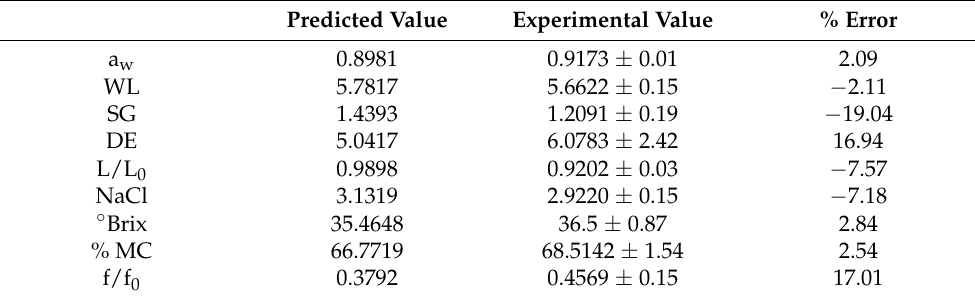
Table 3. Predicted and experimental values for the responses at optimum